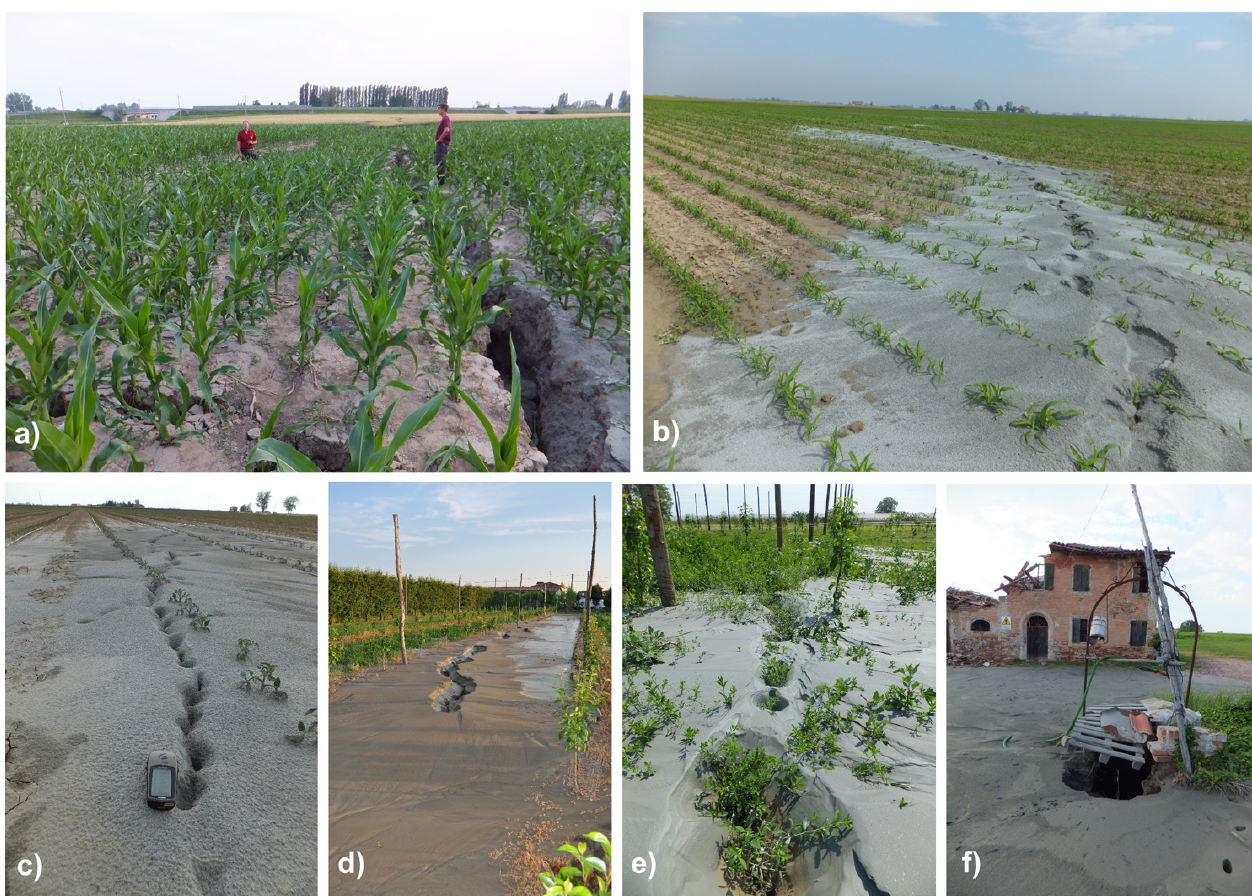
Figure 3. Ground ruptures and associated liquefaction-type phenomena at San Carlo (a), Scortichino (b), Burana (c), Cavezzo (d) and San Possidonio (e). Ejection of copious sand from a water well at San Carlo